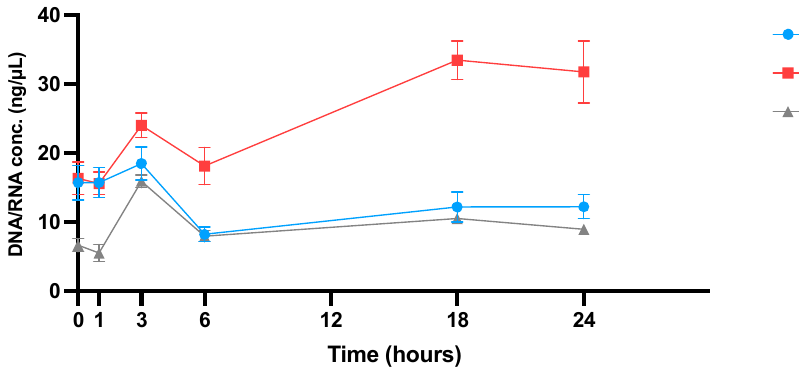
Figure 7. Graphical representation of DNA/RNA leakage (release) dynamics for E. coli ATCC 10536 at several time points of measurement over a 24 h period. The average values measured for each time point for samples of bacteria treated with 2 × MIC of nPt, bacteria treated with ethanol (as positive control), and untreated bacteria (inoculum, i.e., the negative control) are shown (along with standard deviations) and compared.